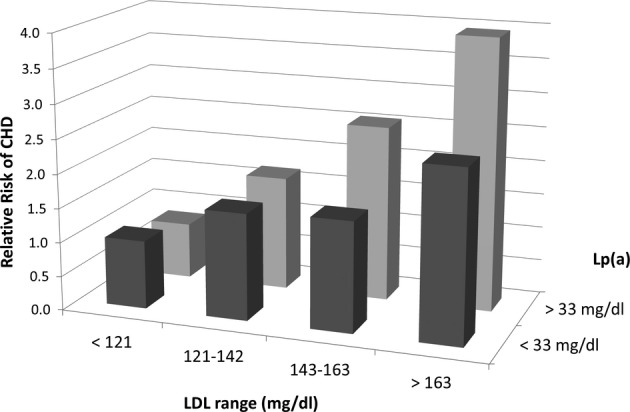
Relation of Lp(a) and LDL-C to CHD riskProspective cohort study of 9,133 middle-aged men, without history of CHD and not on
lipid-lowering therapy. In models adjusted for smoking, diabetes, and hypertension, levels of Lp(a)
and LDL-C were independently predictive of incident CHD [Drawn from data in
Lucet al (2002)].